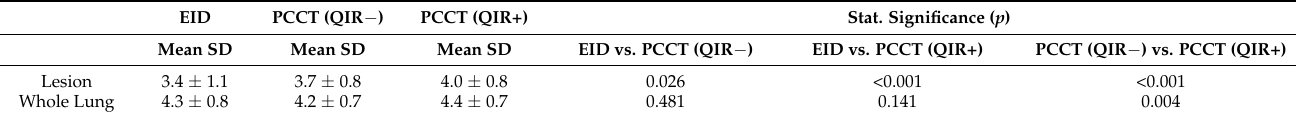
Table 1. Mean values with standard deviation (SD) for overall image quality on EID, PCCT (QIR − ) and PCCT (QIR+) images of enlarged lesions and the whole lung using a 5-point Likert scale as well as their associated p -values. Mean values are based on the rating on the Likert scale assessed by the readers (1—deficient, 2—sufficient, 3—satisfactory, 4—good, 5—very good). Statistical significance was assumed for p -values < 0.05.